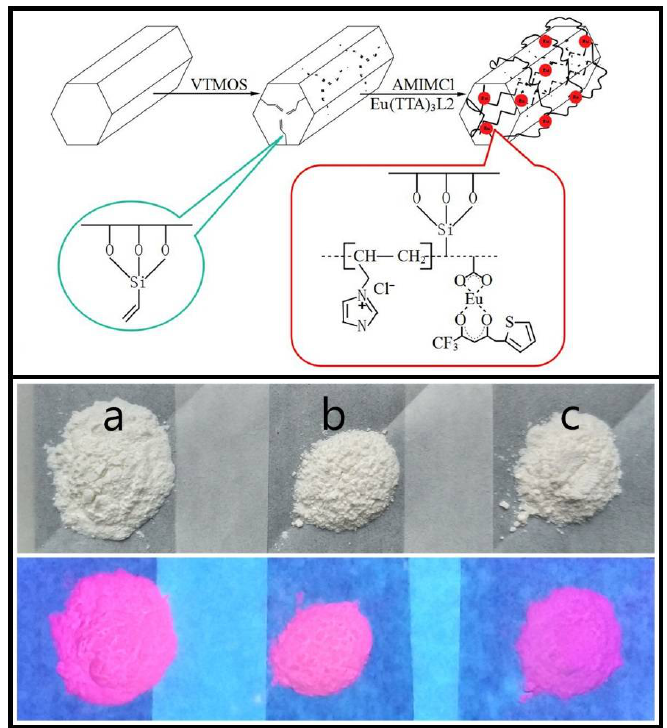
Figure 1. Synthetic scheme of the europium complex hybrid materials, and the photograph of the resulting materials under daylight ( top ) and 360-nm UV lamp ( bottom ). a = Eu@MCM-41-P (IL-AA); b = Eu@MCM-41-P (IL-MAA); c = Eu@MCM-41-P (IL-UA).